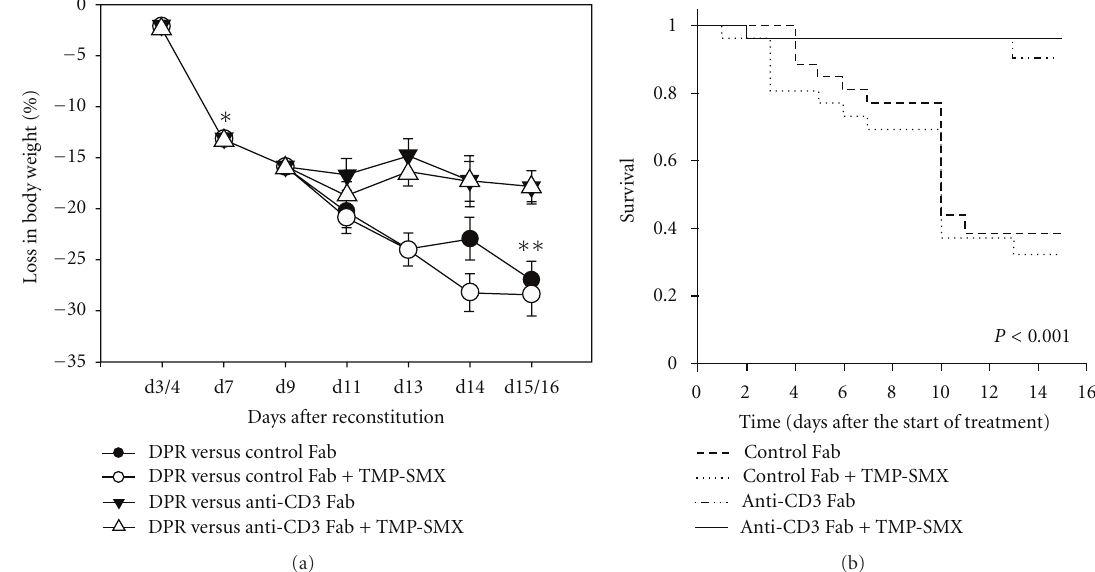
Figure 1: Changes in the body weight and survival rate of experimental mice. (a) Percent loss of body weights (compared with the peak weight) for di ff erent groups of experimental mice is plotted against the days after reconstitution. Each data point represents arithmetic mean ± SEM. (b) The Kaplan-Meier plot of survival analysis. Survival data of mice pooled from three experiments were summarized in the figure. Proportion of survivors versus time (days after treatment start) are plotted. To make the analysis more conservative, the mice that were sacrificed for lung function and inflammatory measurements were assumed to survive until the last day of the experiment. Kaplan- Meier Log Rank Test was performed using Sigma-Stat 3.5, which was found to be significant ( P < 0 . 001) (Copyright 2010, The American Association of Immunologists,